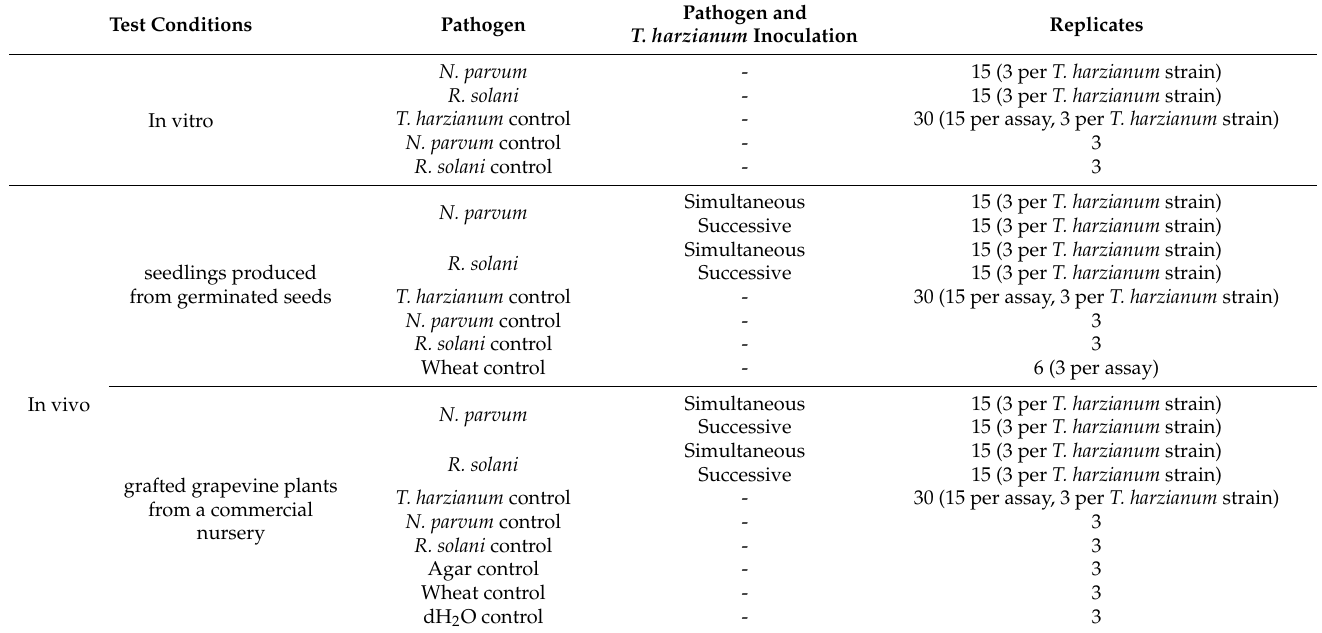
Table 1. Summary of the experimental assays carried out for each pathogen and T. harzianum